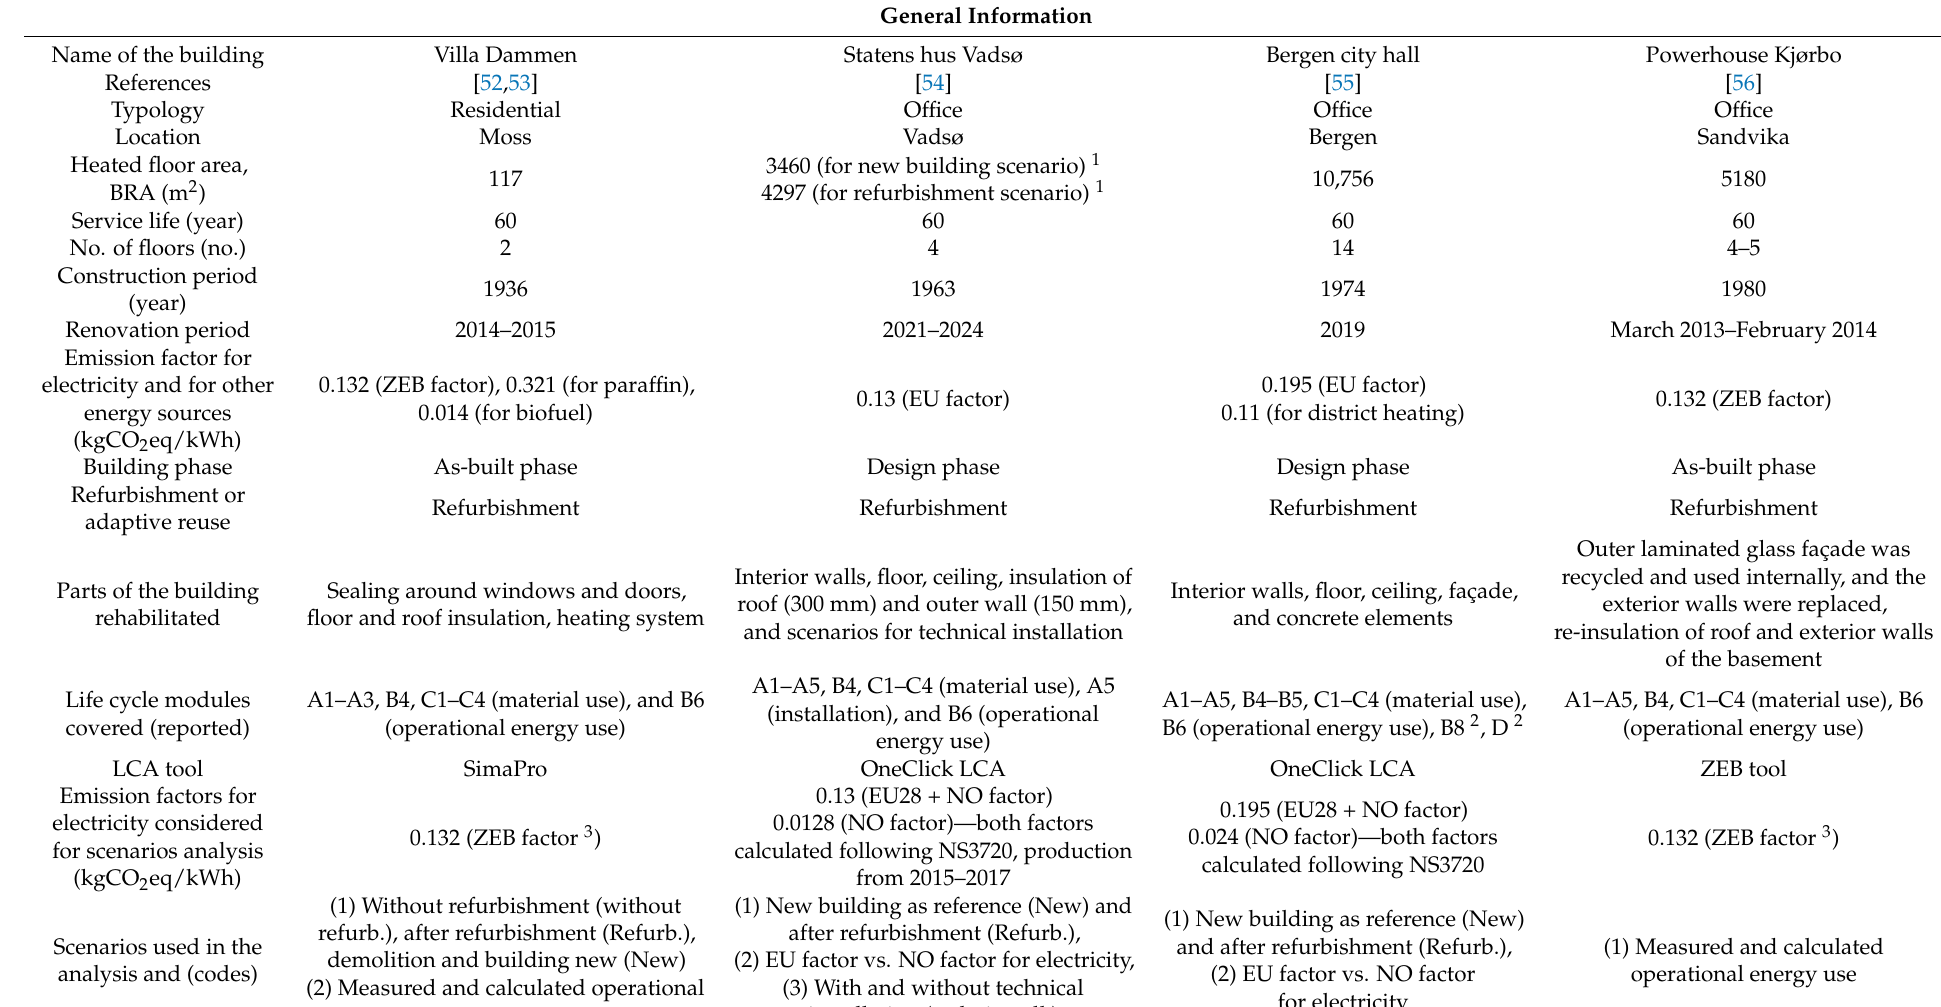
Table 1. Summary of case studies considered in this